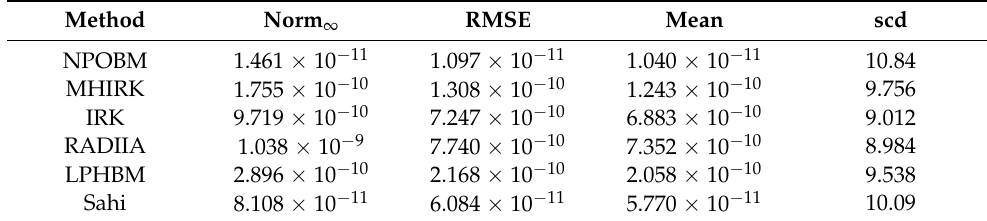
Table 15. Numerical results for Problem 4 with NS = 2 8 , where x ∈ [ 0,10 ] .